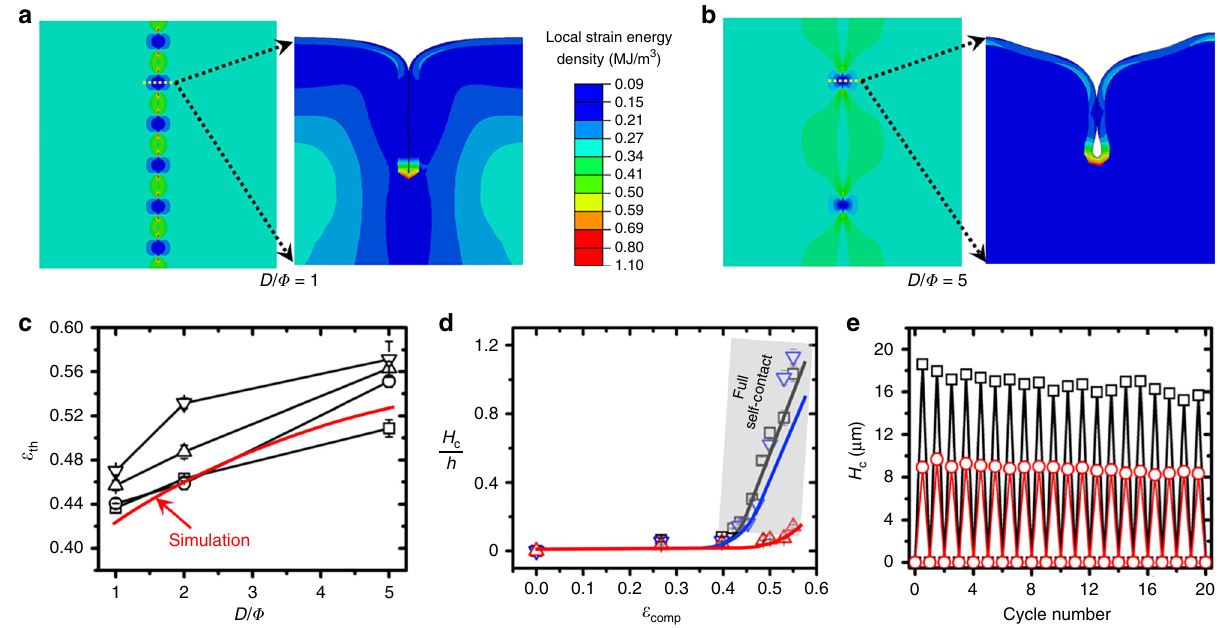
Fig. 3 Numerical analysis and reproducibility assessment. In-plane and out-of-plane strain energy analyses for the surfaces with a single micro-hole array ( Φ = 40 μ m) of ( a ) D / Φ = 1 and ( b ) D / Φ = 5, at ε comp = 0.5. c Comparison of the simulated ε th (threshold strain of hole closure) with experimental ones at different D / Φ for the surface with hole array ( ☐ for Φ = 20 μ m, O for Φ = 40 μ m, Δ for Φ = 60 μ m, ∇ for Φ = 80 μ m). d Comparison the simulation (line) and experimental (symbol) results for nominal self-contact depth ( H c / h ) under a progressive ε comp for the surface with a single micro-hole array ( Φ = 40 μ m; black for D / Φ = 1, blue for D / Φ = 2, red for D / Φ = 5). e The cyclic testing results with Φ = 80 μ m ( ☐ ) and Φ = 40 μ m (O), at D / Φ =